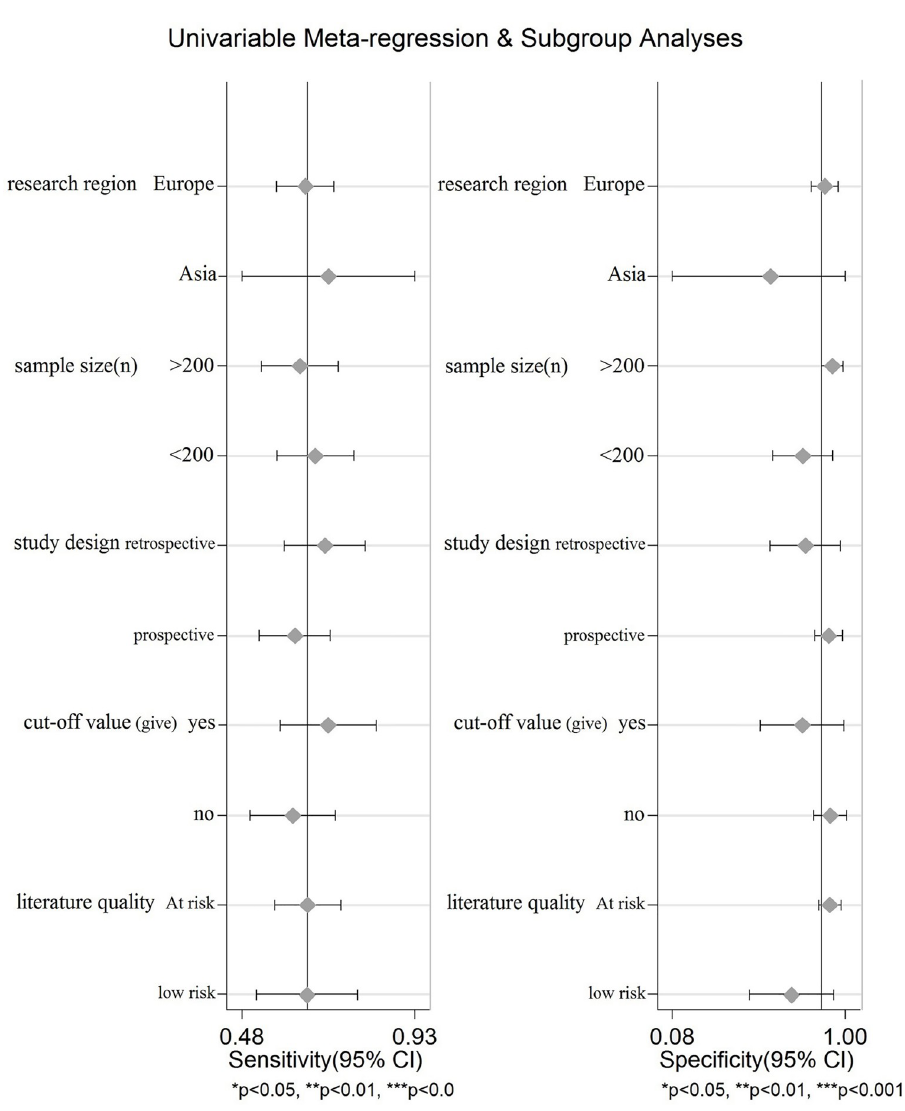
Fig 4. Meta-regression and subgroup analyses for potential sources of heterogeneity. The forest plots show the pooled diagnosis index of TIMP-1 for the diagnosis of CRC in specified covariates. The pooling symbol is shown as point. P-values of covariants in the meta-regression analysis are more than 0.05, which shows that none of the factor that is responsible for the heterogeneity.